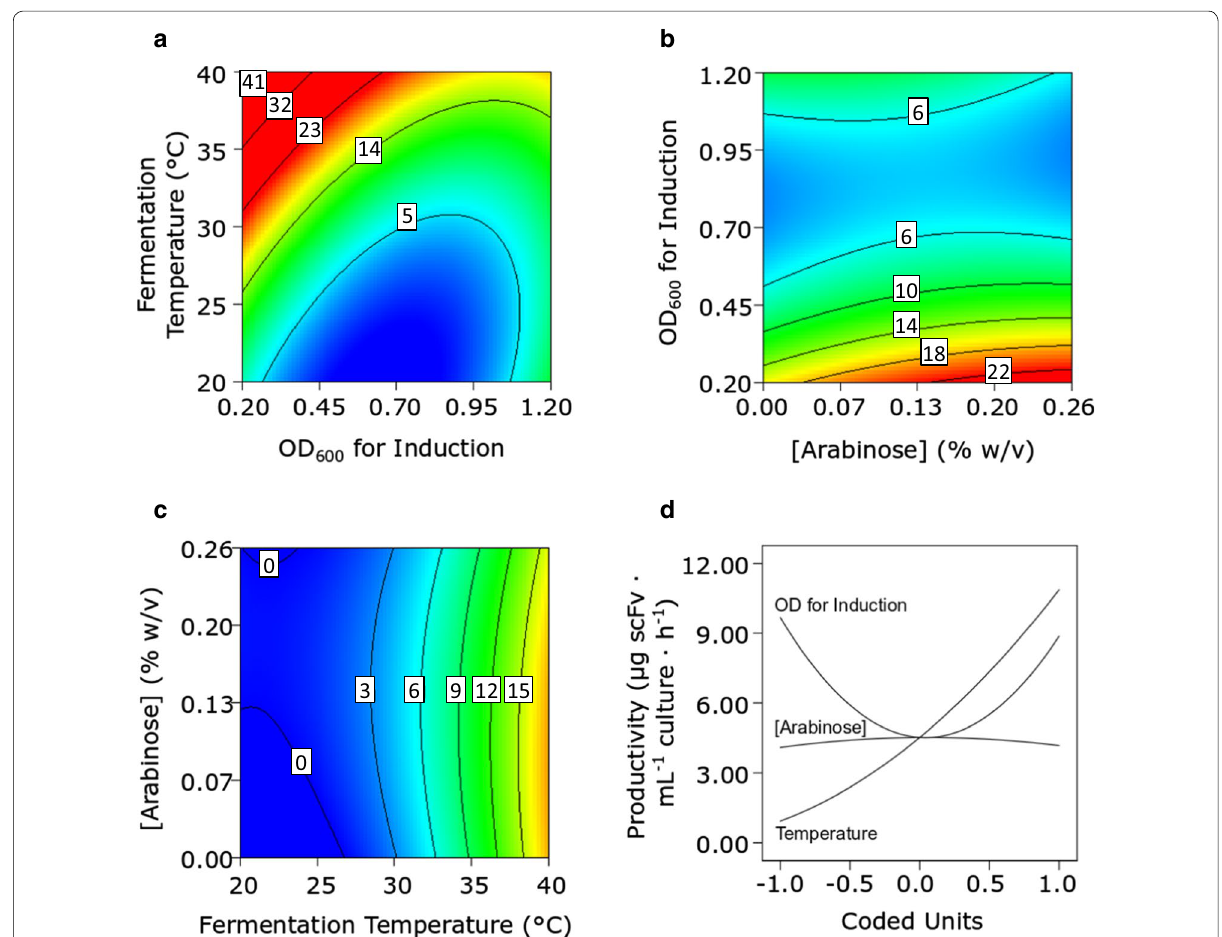
Fig. 1 Response ( a – c ) and perturbation ( d ) plots for the whole cell productivity of DsbA sp -scFv. Response plots show the response of two factors; the third invariant factor is set at level ‘0’. Units in response plots are µg scFv mL − 1 culture h −